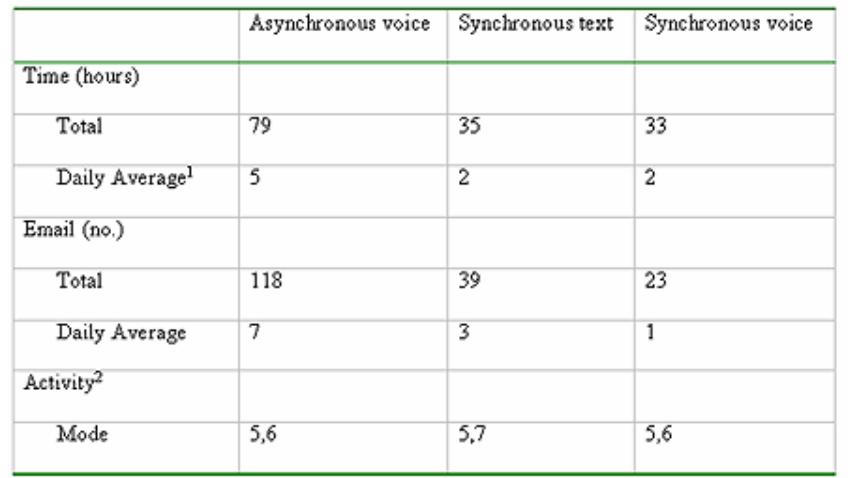
Table 1. Summary of the Groups'Activity-Time